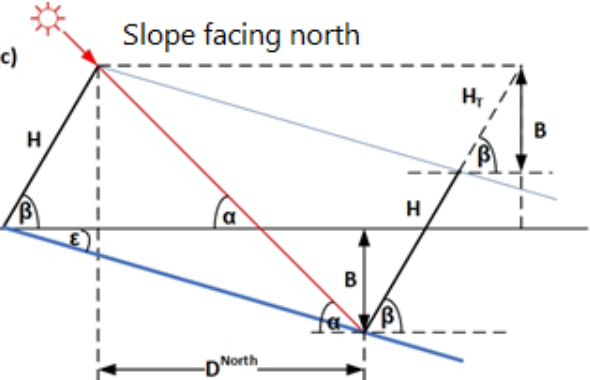
Figure 1. ( a ) Collectors deployment on planes ( b ) horizontal with D h , sloped planes facing south with D south and ( c ) sloped planes facing north with D north , blue lines represent the ground.